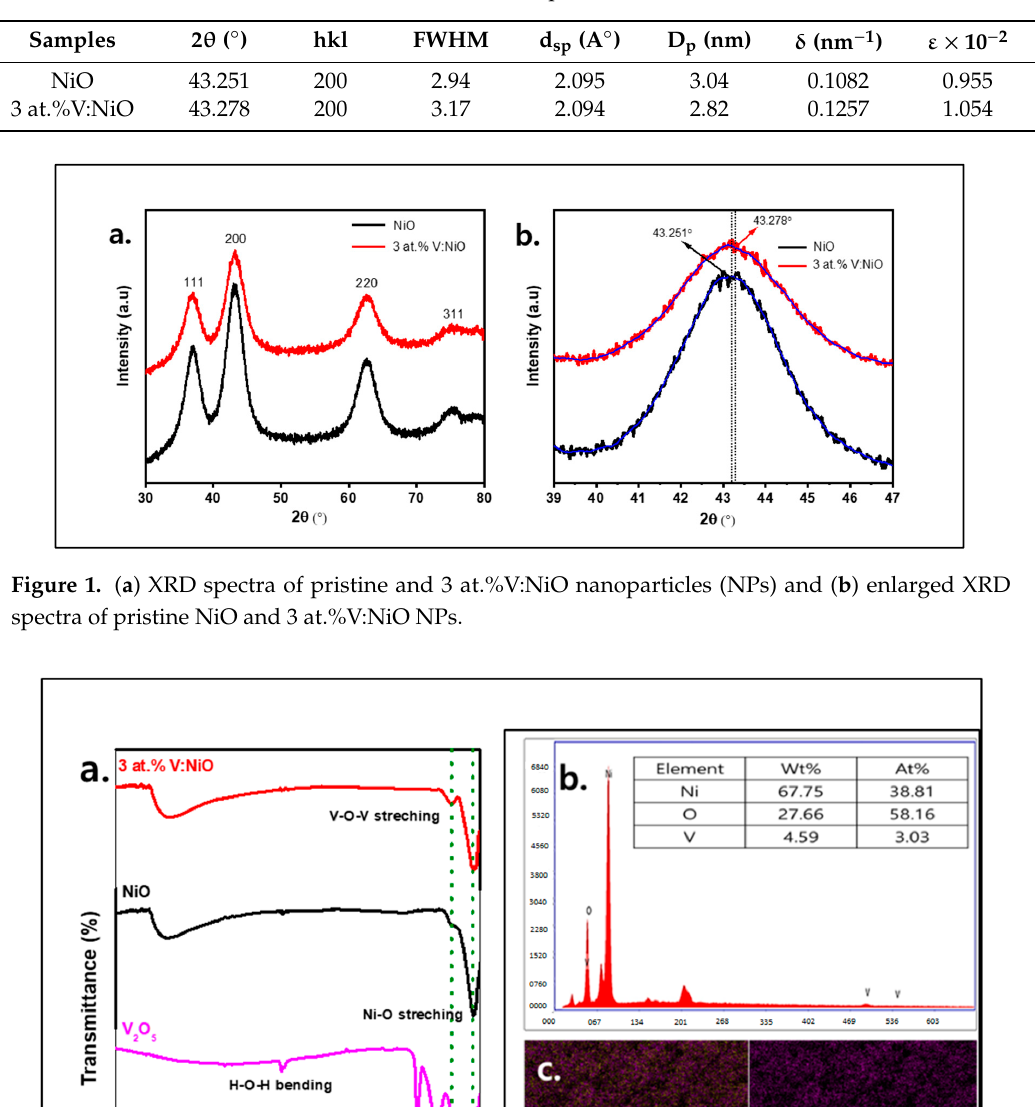
Table 1. Measured values of structural parameters for NiO and V:NiO.